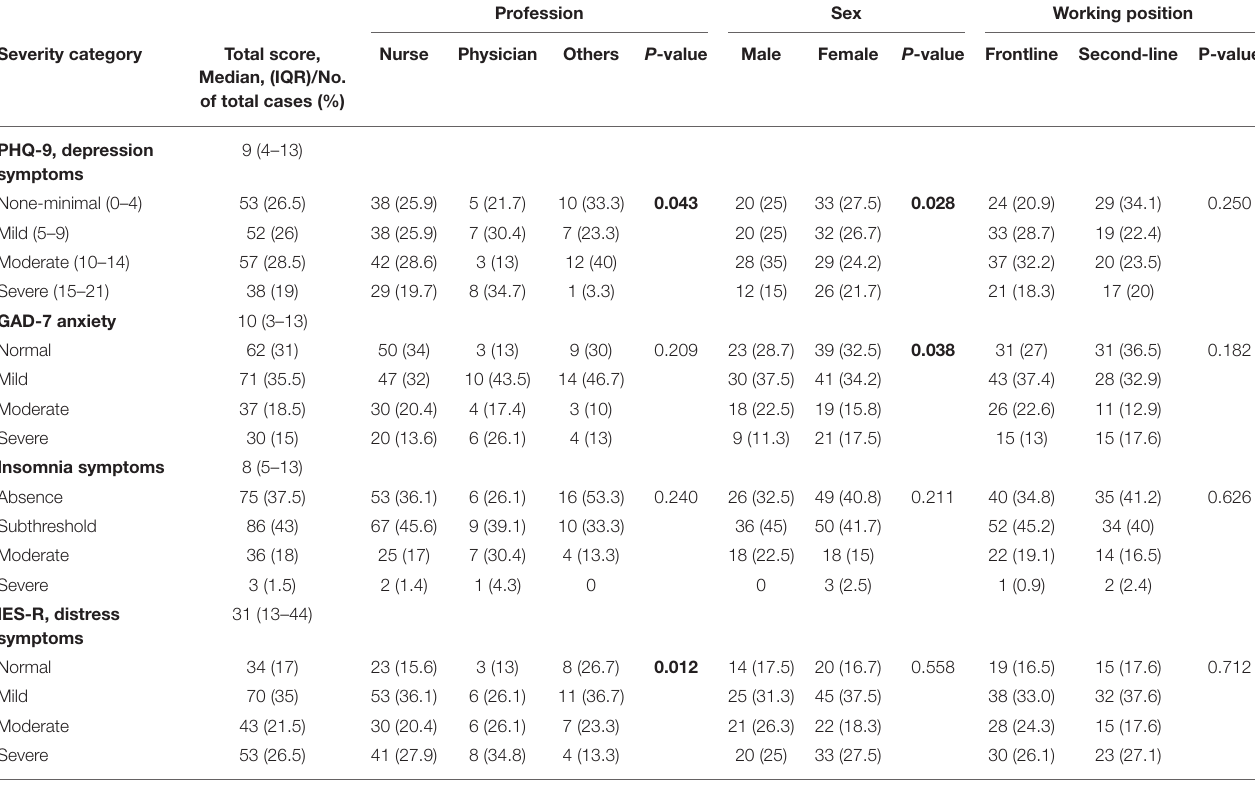
TABLE 2 | Level of depression, anxiety, insomnia and distress among healthcare providers in total cohort and subgroups. Profession Sex Working position Severity